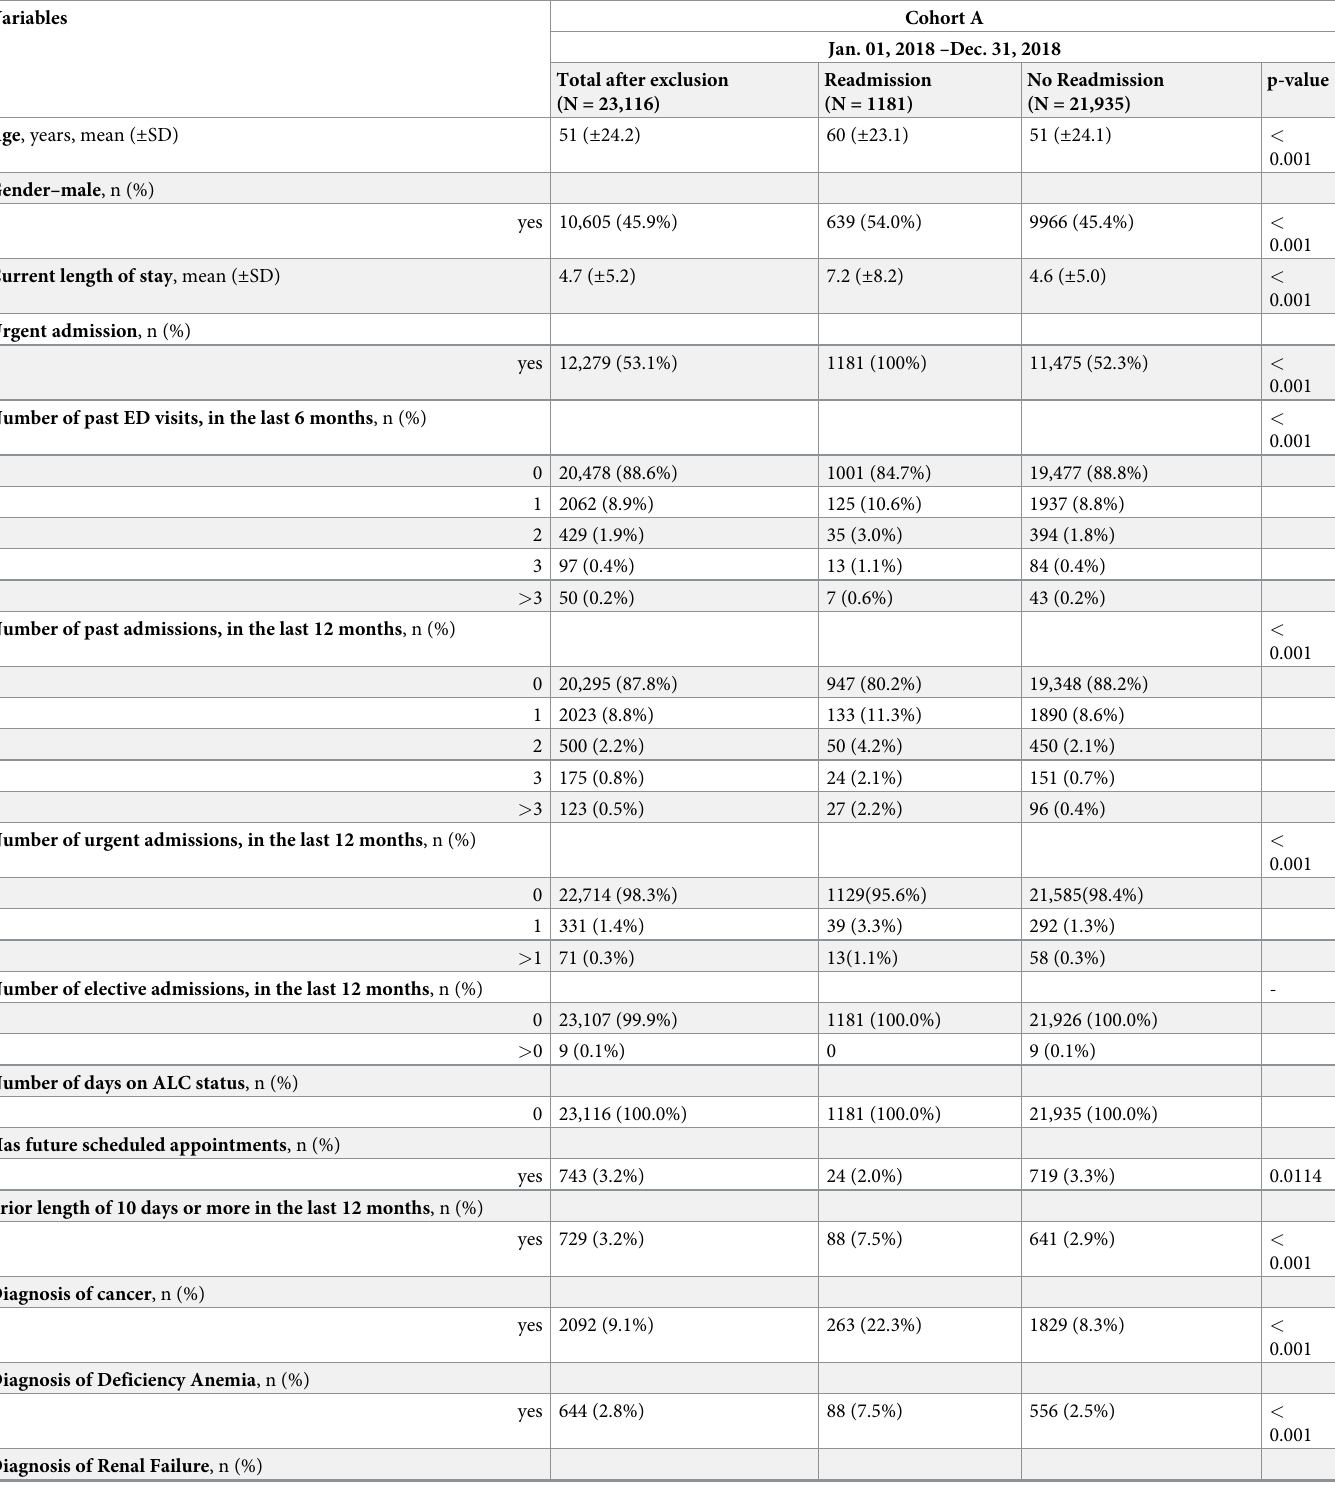
Table 5. Baseline characteristics—predictor